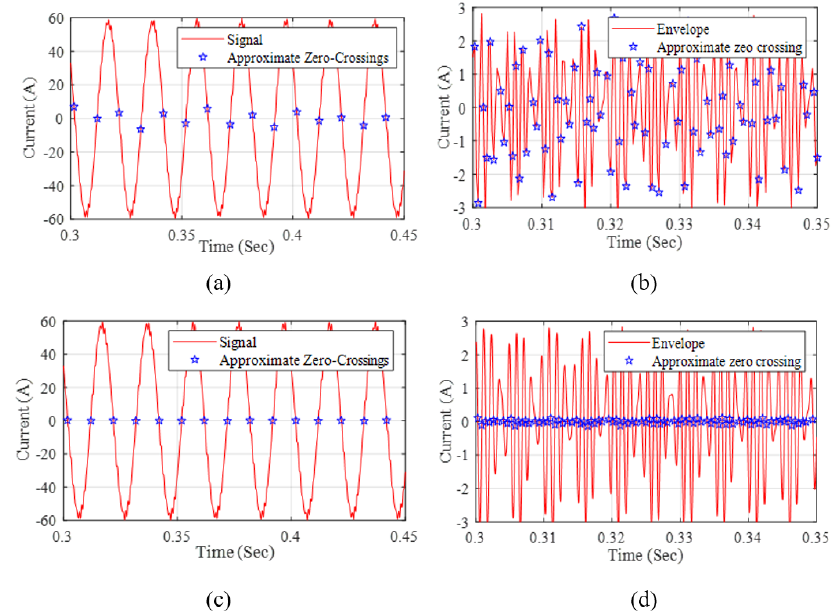
Figure 7. ( a ) The stator current and approximate zero crossings at a sampling frequency of 4 kHz, ( b ) the corresponding envelope shifted across zero line with approximate zero crossings, ( c ) the signal with improved sampling frequency and approximate zero crossings, and ( d ) the corresponding envelope shifted across zero line with approximate zero crossings.